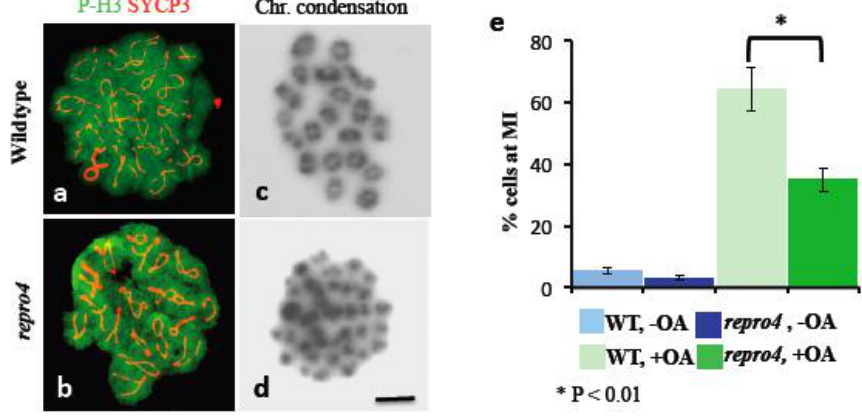
Figure 4. The OA-induced G2/MI transition is not normal in repro4 mutant spermatocytes. After treatment of spermatocytes with okadaic acid in vitro , phosphorylation of histone H3 (green) around the SYCP3 axes of the synaptonemal complex (red) occurred in both WT ( a ) and repro4 mutant ( b ) spermatocytes. ( c ) shows the normal chromosome configuration after spermatocytes were treated with OA in vitro , and ( d ) shows a representative chromosome configuration after repro4 mutant spermatocytes were treated with OA in vitro . ( e ) presents these observations graphically and demonstrates that about 65% WT spermatocytes formed condensed and individualized bivalent chromosomes, whereas significantly fewer ( p < 0.01, about 30%) repro4 mutant spermatocytes formed condensed and individualized bivalent chromosomes. This experiment was performed 3 times, with at least 200 spermatocytes counted per